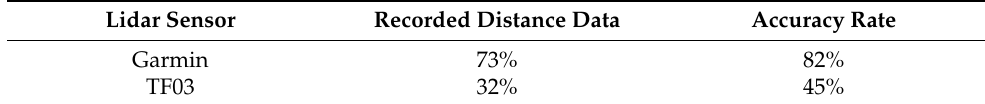
Table 2. Comparisons of the two lidar sensors (TF03 and Garmin).